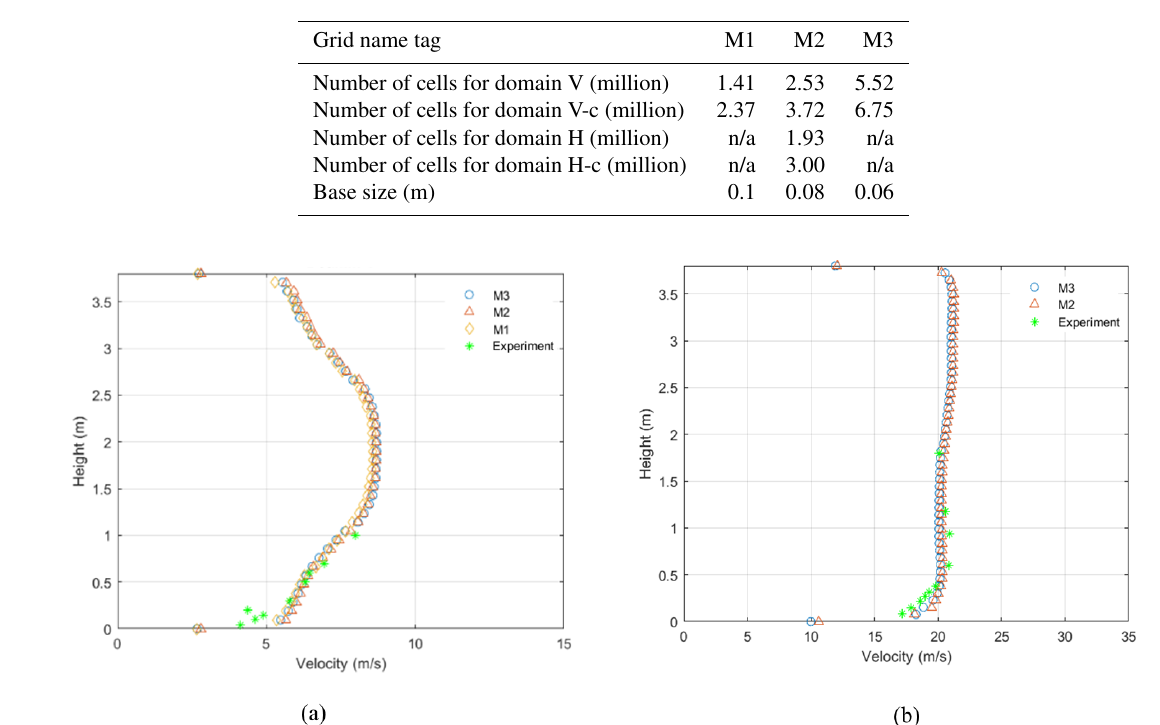
Figure 3. The mean ABL velocity profiles at the test section for different mesh setups compared with the experimental data (Hangan et al., 2016), (a) low speed (without contraction) and (b) high speed (with contraction) mean velocity vertical